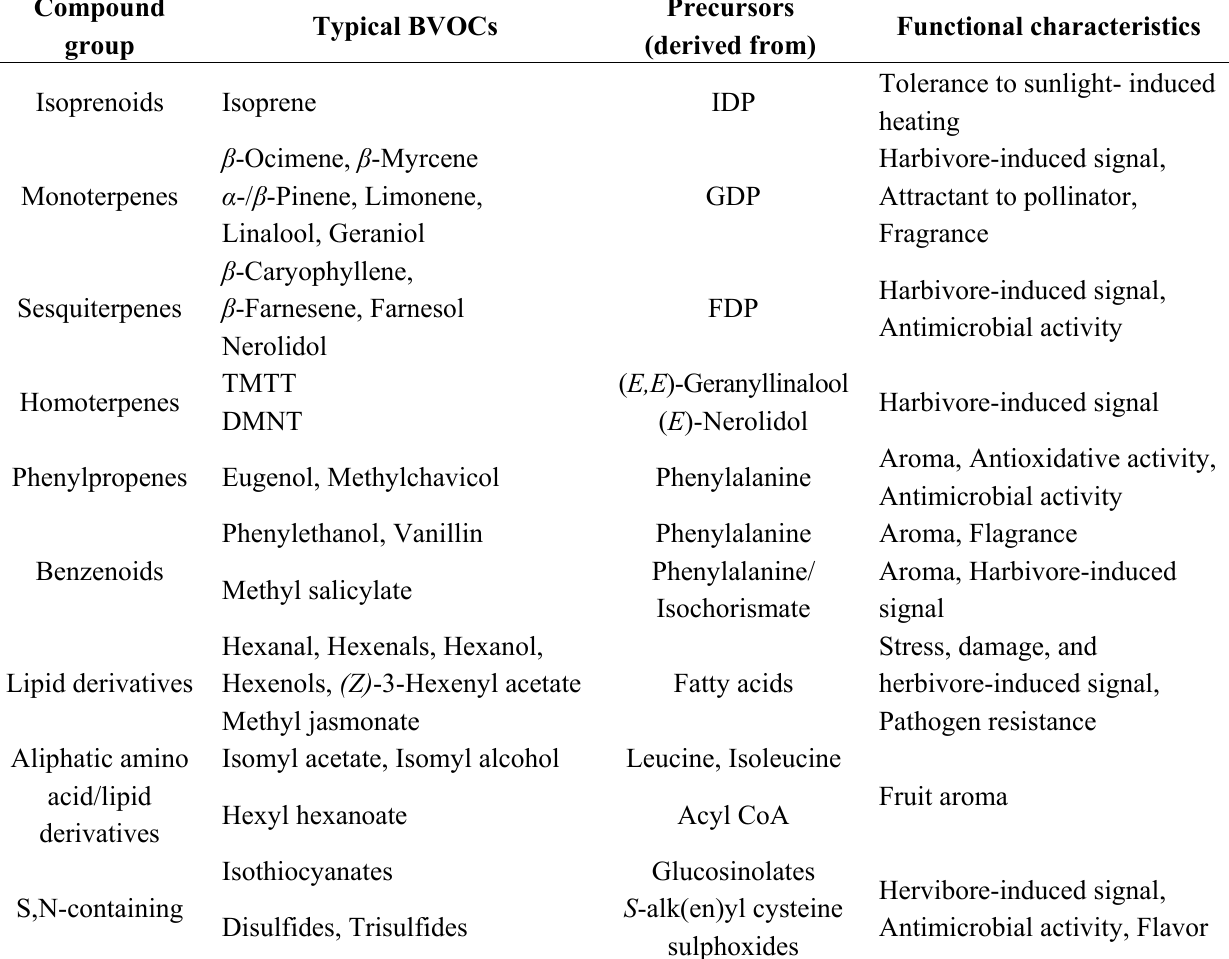
Table 1. Main groups of plant-produced biogenic volatile organic compounds (BVOCs) and their functional